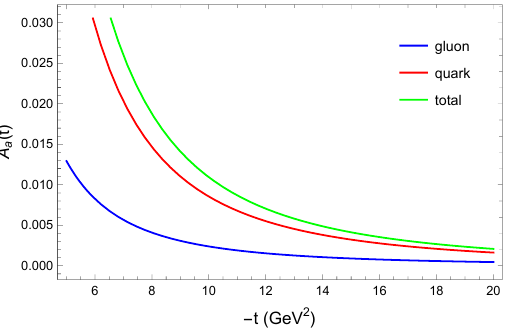
Figure 3. Comparisons of A q,g ( t ) and A ( t ) with the nucleon DAs estimated from QCD sum rule [81,